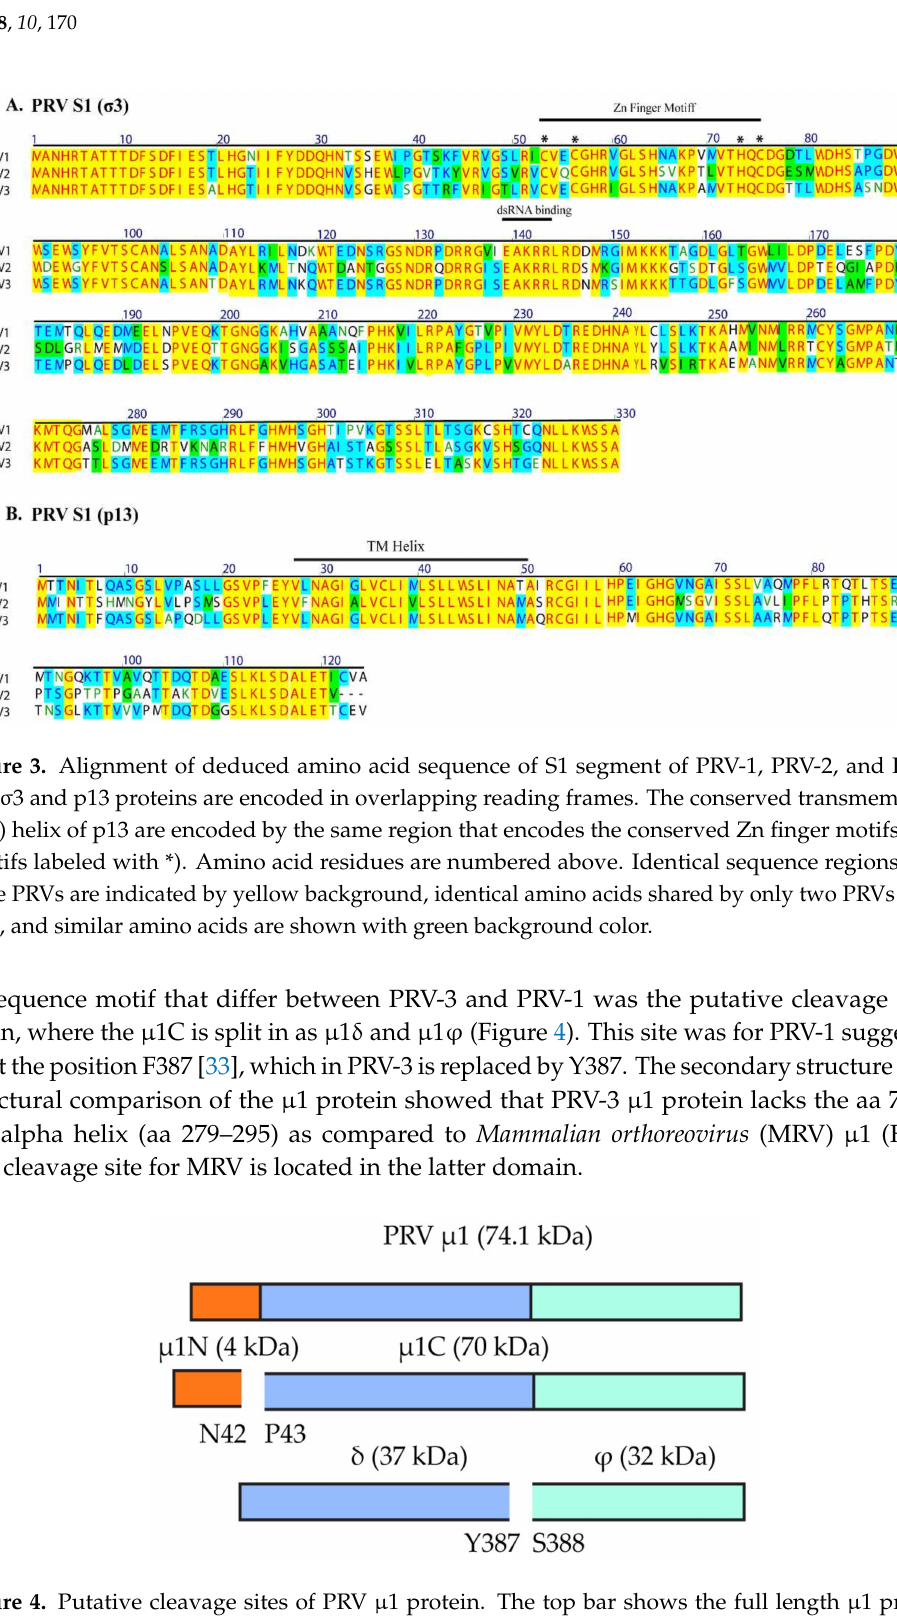
Figure 4. Putative cleavage sites of PRV µ 1 protein. The top bar shows the full length µ 1 protein, the middle bar shows the cleavage site of the N-myristoylated fragment µ 1N and the bottom picture represent µ 1C cleavage. The second cleavage site at position 387, which generates the δ / ϕ fragments, has a F387 for PRV-1, which in PRV-3 is replaced by